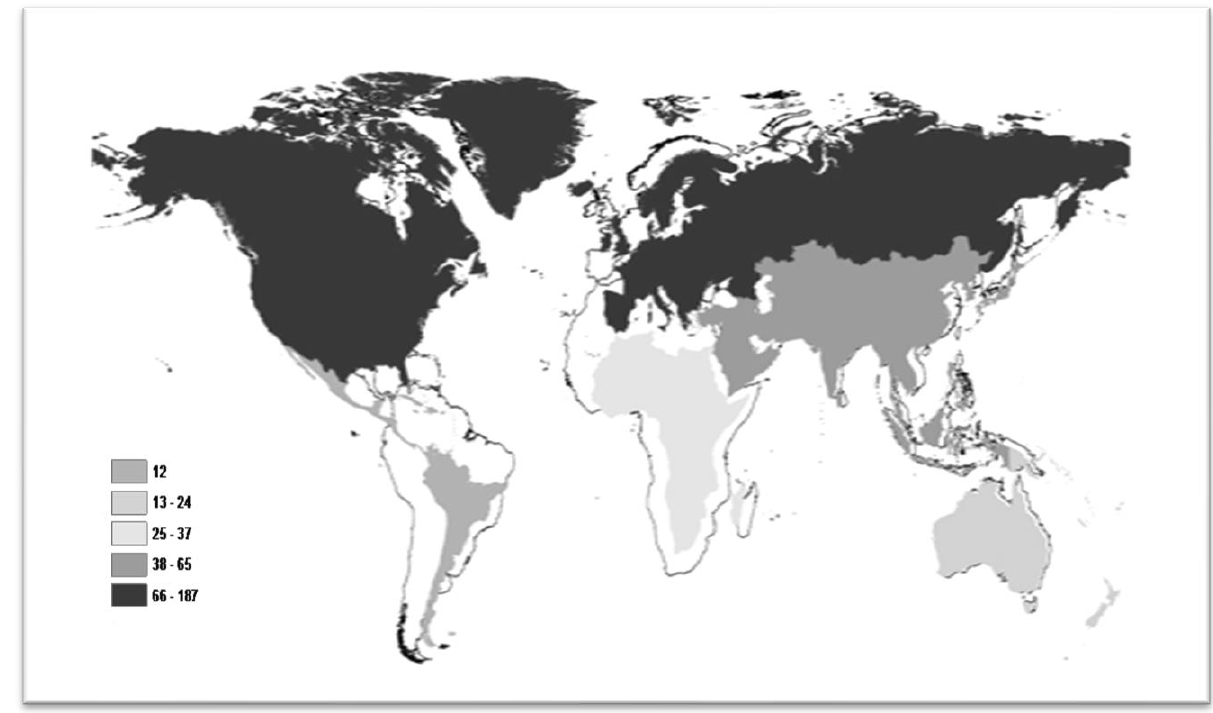
Figure 2: Resized world map according to the knowledge-production concentration of Crimes of the powerful research articles according to which region the studies were focused/developed (WoS Core Collection search) (N=475)( *)